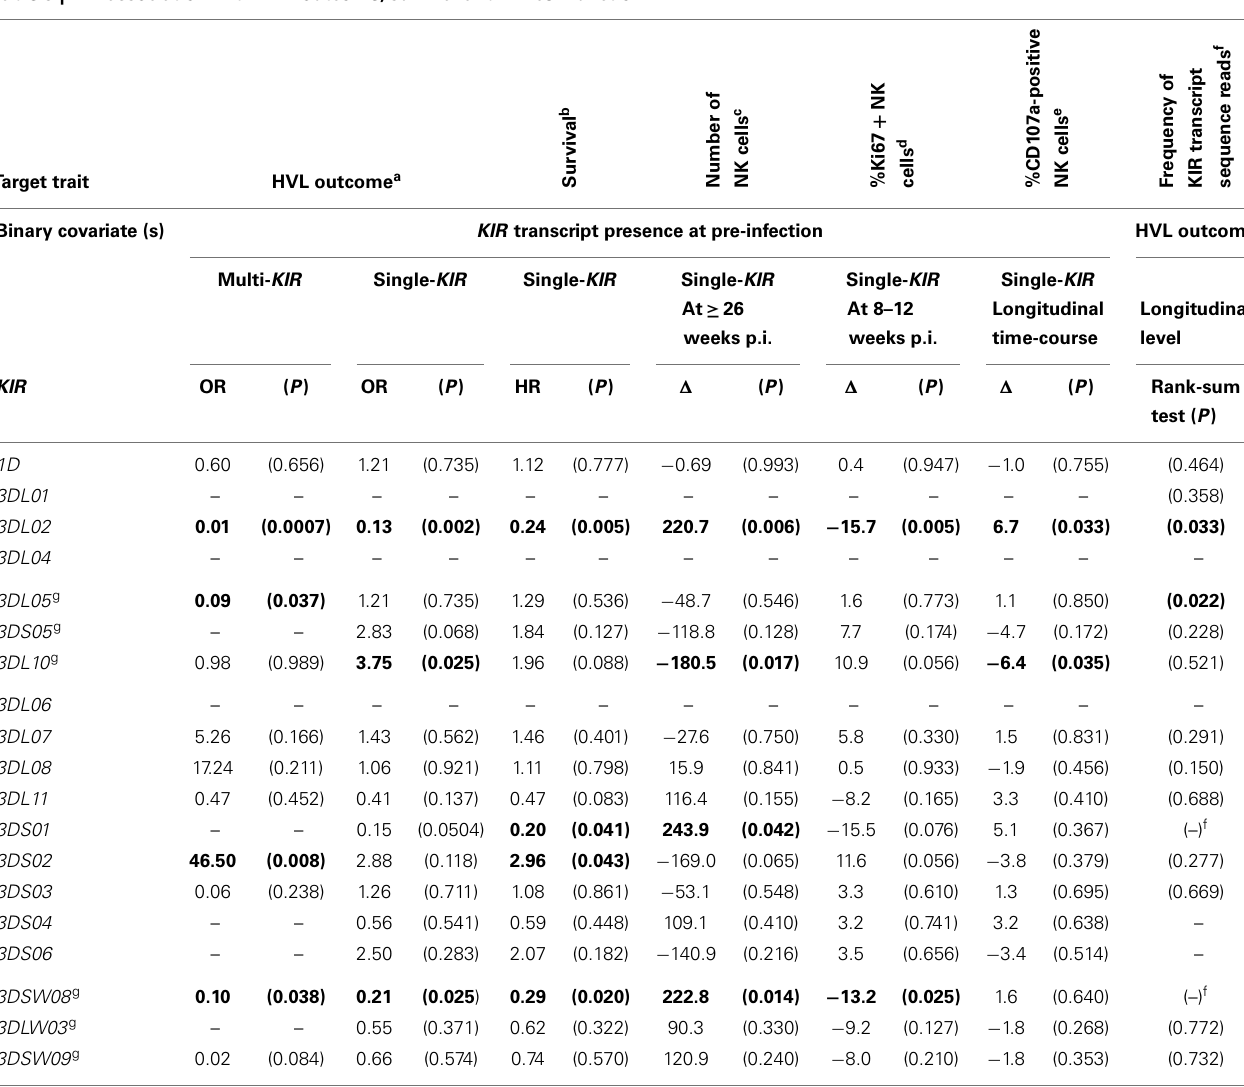
Table 3 | KIR association with HVL outcome, survival and NK cell function